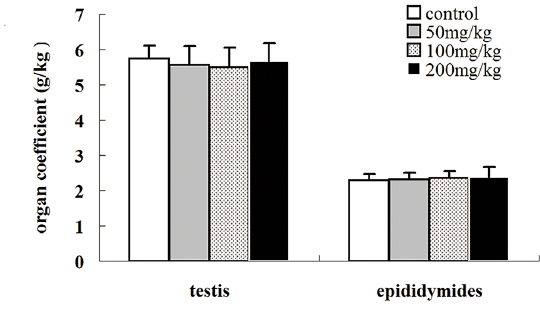
Figure 2. Effects of icariin on the coefficients of the testes and epididymides of SD rats treated with different doses of icariin. Values are the mean ± SD of 10 rats.